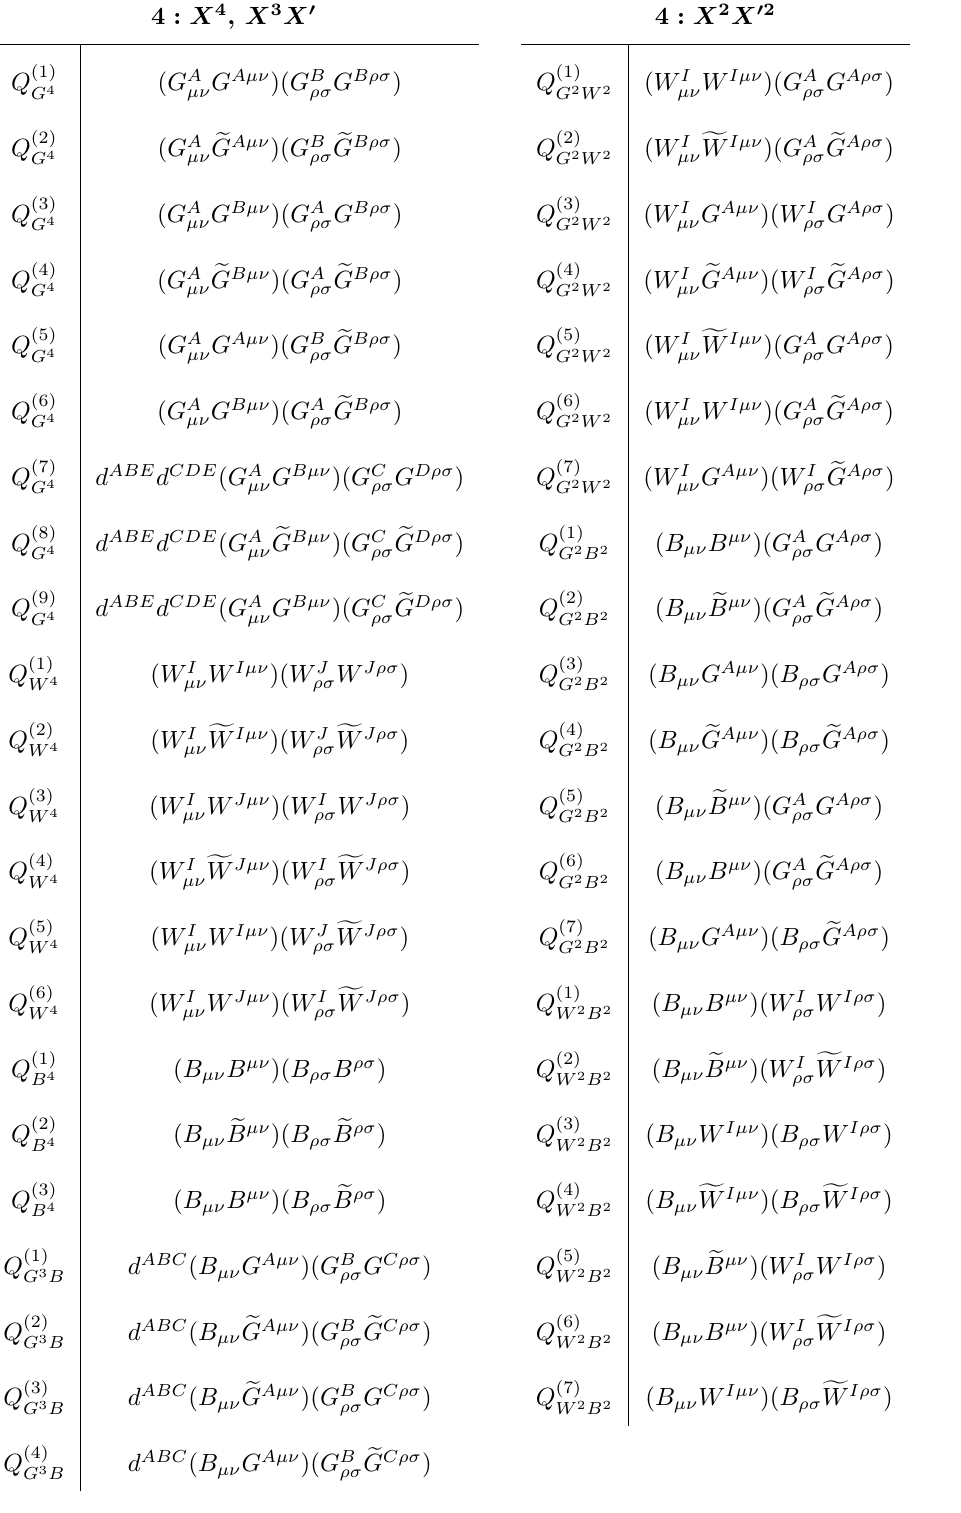
Table 7. The dimension-8 SMEFT operators constituted only of field strength